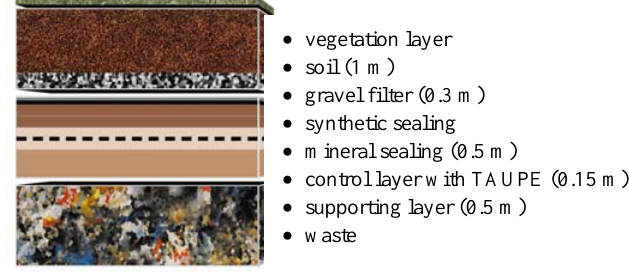
Figure 9 . Schematic sketch of a surface barrier system of a waste disposal site.